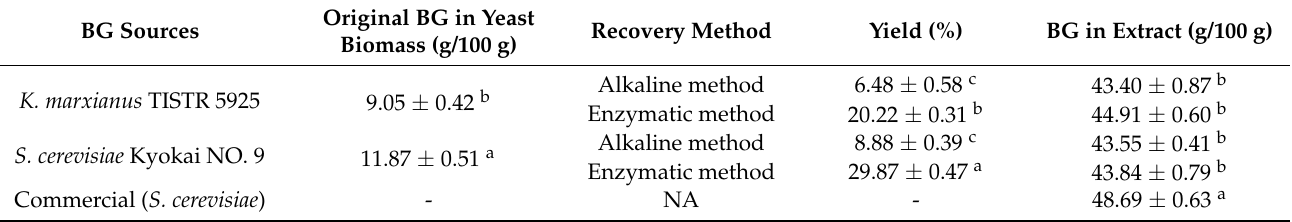
Table 1. BG content and yield after alkaline and enzymatic recovery from K. marxianus TISTR 5925, S. cerevisiae Kyokai NO. 9, and commercially available